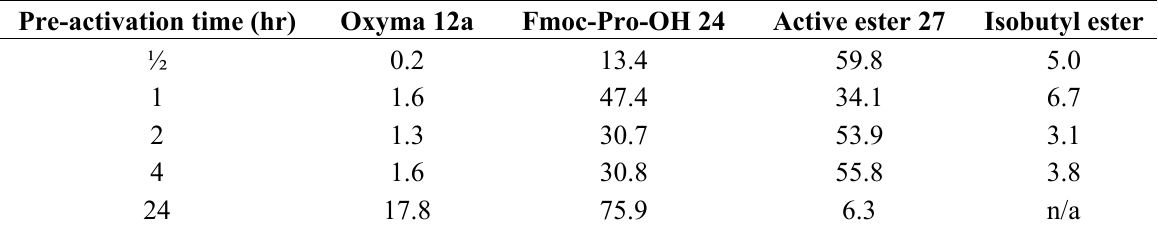
Table 11. The rate of formation of the active ester of Fmoc-Pro-OH 24 using